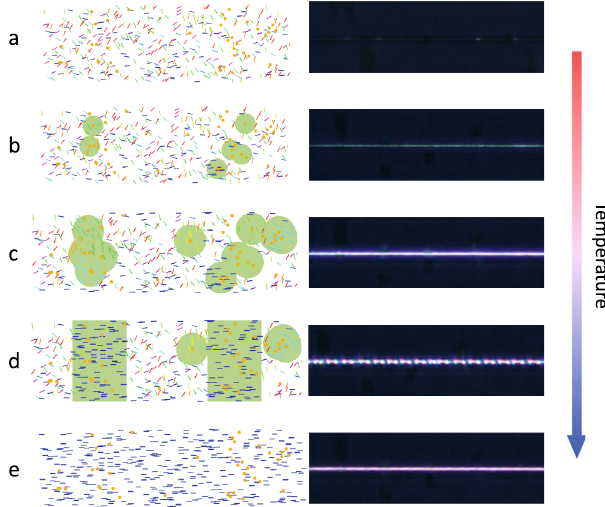
Fig. 5 Schematic representation of the isotropic-nematic phase transition and video frames of the 6 μ m capillary during its cooling, with the temperature decreasing from top to bottom. a Isotropic state of the liquid crystal nanocomposite; the bars represent the colour coded local orientation of the liquid crystal molecules and the yellow circles the gold nanospheres. b – d Formation and growth of nematic domains in the nanoparticle-poor and nanoparticle-rich regions (green areas), with a time delay. e Homogeneous nematic state of the liquid crystal